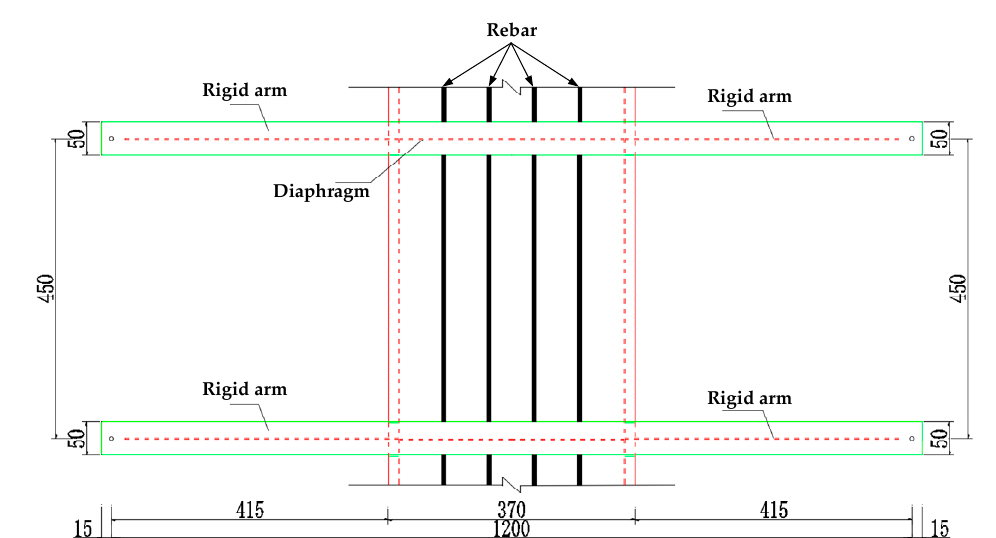
Figure 5. Schematic plan view of the main beam (unit: Mm).